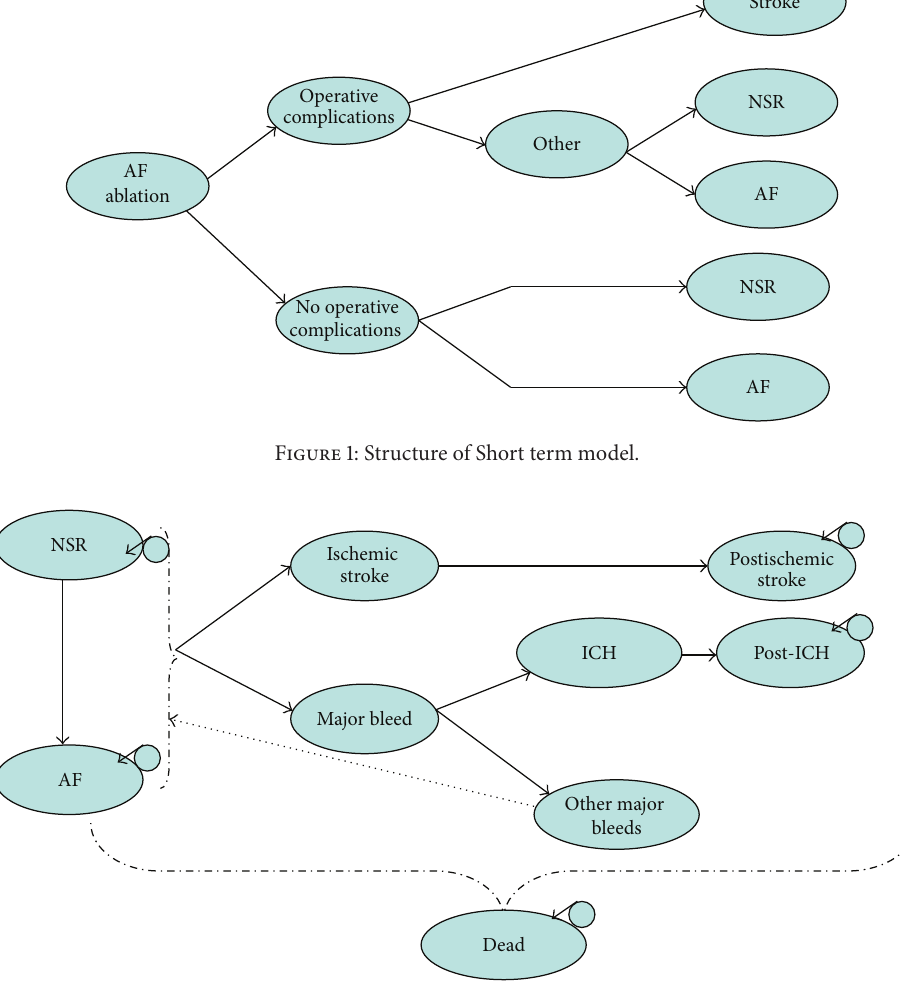
Figure 2: Structure of long-term model.